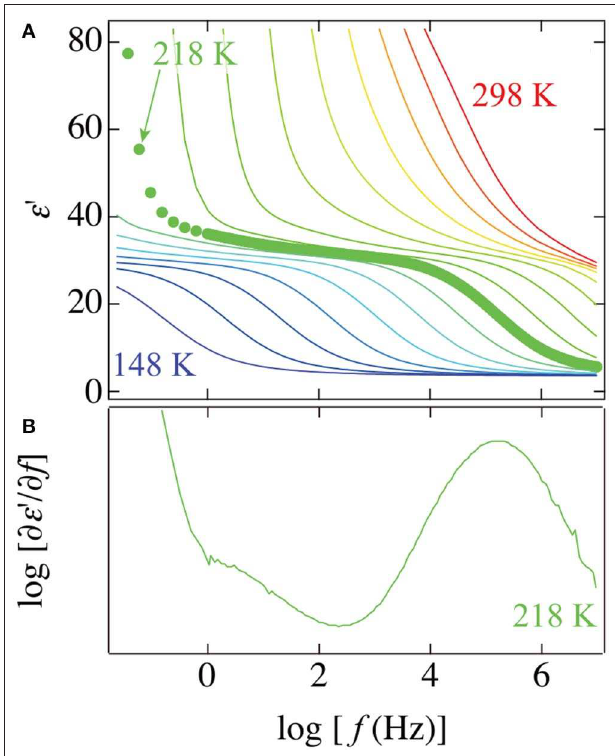
FIGURE 3 | The frequency dependence of (A) the real part of permittivity at temperatures from 148 to 298K in steps of 10K and (B) the frequency derivative of the real part of permittivity at 218K for the 65 wt% PVP–water mixture. Plots in the panel (A) indicate a spectrum at 218K.